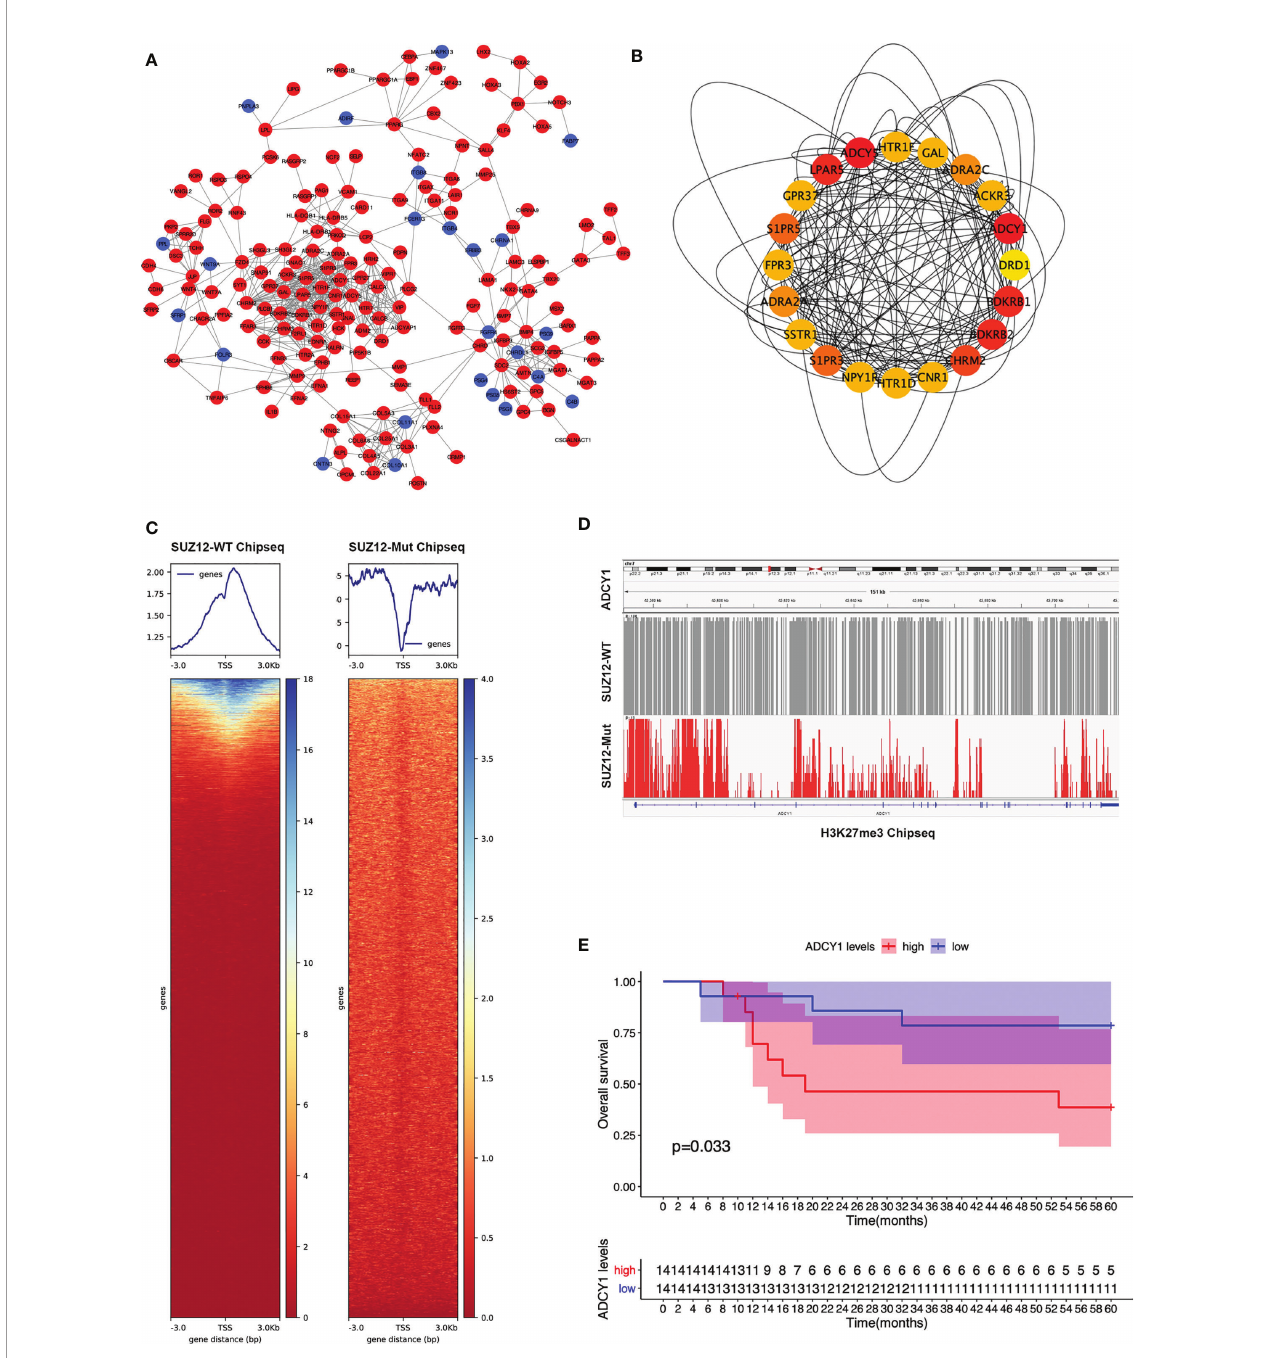
FIGURE 2 | PPI network construction and the selection of hub genes. (A) The STRING database constructed the PPI network of DEGs. The red node represented the upregulated genes, and the blue node represented the downregulated genes. (B) The maximal clique centrality (MCC) algorithm was used to identify hub genes. The red node represented the gene with a high MCC score, while the yellow node represented the gene with a low MCC score. (C) Distribution of H3K27me3 in the TSS region of SUZ12-Mut and SUZ12-WT cells. The distribution of H3K27me3 was increased in SUZ12-WT cells and decreased in SUZ12-Mut cells. (D) The distribution of H3K27me3 in ADCY1 promoter region and genosome were compared and the result showed that it was signi fi cantly sparse in SUZ12-Mut cells. (E) Overall survival of hub gene ADCY1 was performed using COX survival analysis. P < 0.05 was considered statistically signi fi